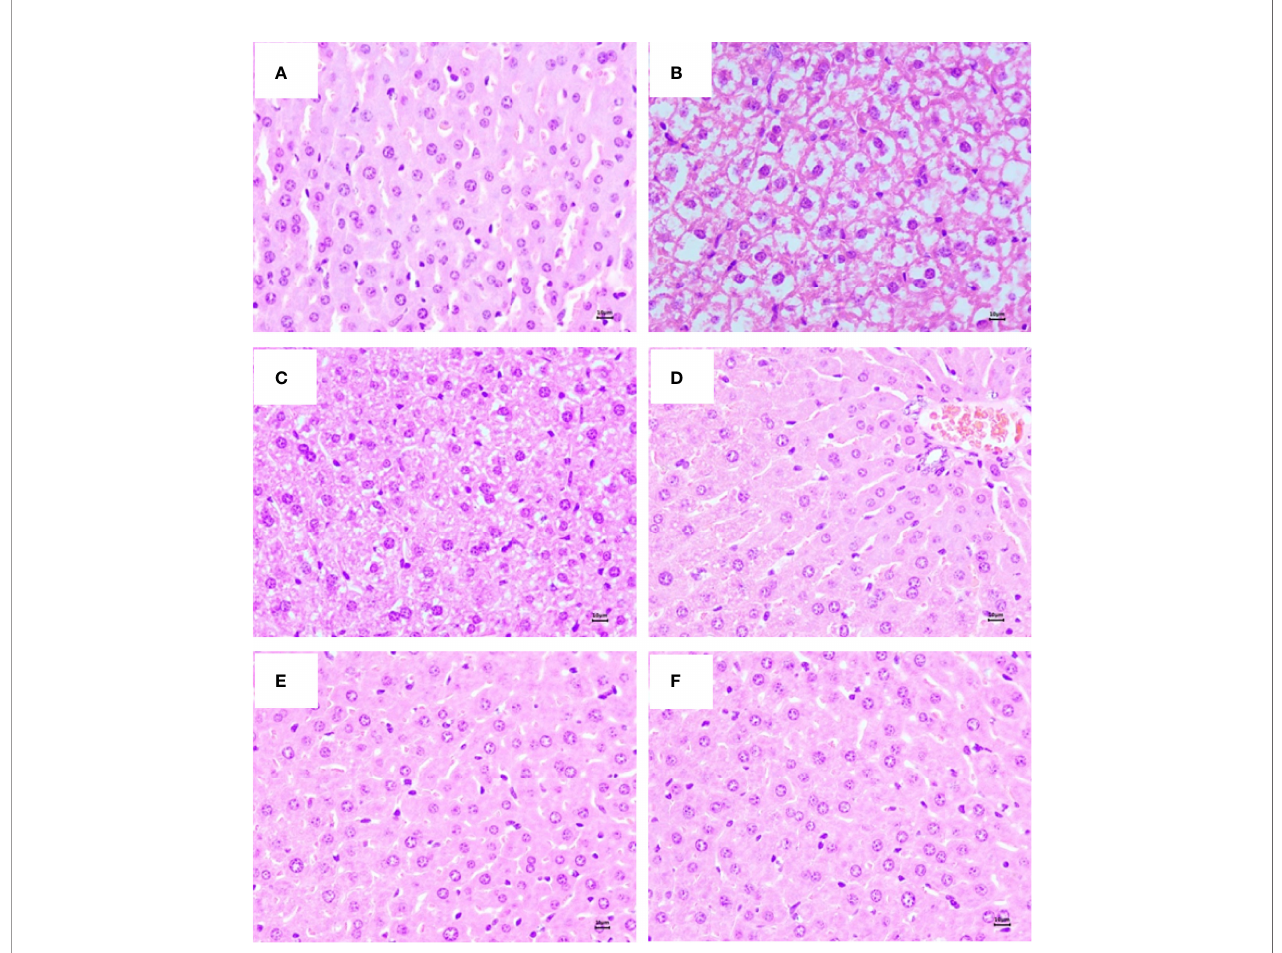
FIGURE 2 | Representative photography (hematoxylin and eosin, HE, mangni fi cation,×40, 10 m m) staining of liver in mice. (A) Control group; (B) Model group; (C) AG-HCl group. (D) GP-L group. (E) GP-M group. (F) GP-H